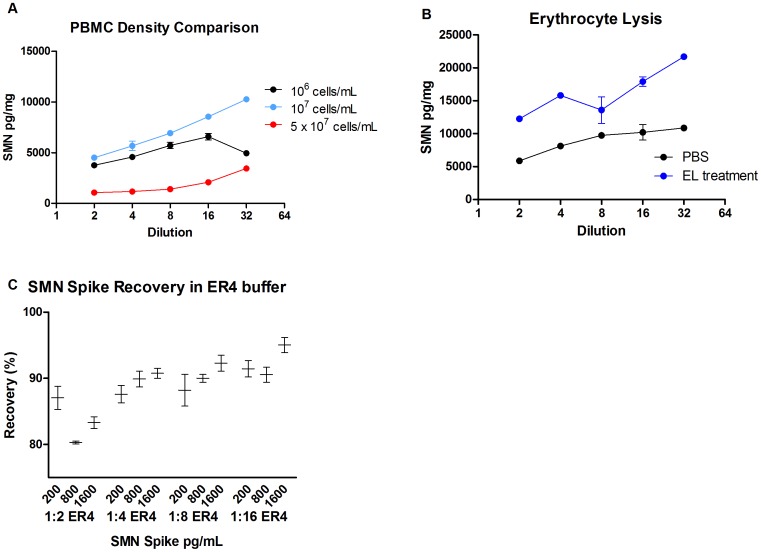
Optimizing cell densities and reagents for lysis and SMN extraction.To examine the impact of lysates and lysis reagents on SMN signal a number of factors were tested. A: SMN signal was evaluated in lysates created from a single sample purchased from AllCells. PBMCs were processed in ER4 at densities of 106, 107 and 5×107 cells/mL and the resulting lysates diluted from 1∶2 to 1∶32 for analysis in the SMN ELISA. At the highest concentration SMN signal was linear with adjusted dilutions until after 1∶16, suggesting interference at this density. Concentrations of 106 and 107 cells/mL had parallel linear increases in signal between 1∶2 and 1∶8, with the 107 dilution continuing to rise at the 1∶32 dilution. B: Treatment of PBMCs in erythrocyte buffer for 5 minutes increased the SMN signal by roughly twofold over the untreated cells. C: SMN protein standard was formulated in different dilutions of ER4 at different concentrations to determine the impact on spiked SMN signal recovery. Use of 1∶4 to 1∶16 ER4 reagent allowed for >90% signal recovery across several SMN levels. Error bars represent standard deviations in Figures 4A–B. In Figure 4C error bars indicate the minimum and maximum values while the horizontal bar indicates the median value.